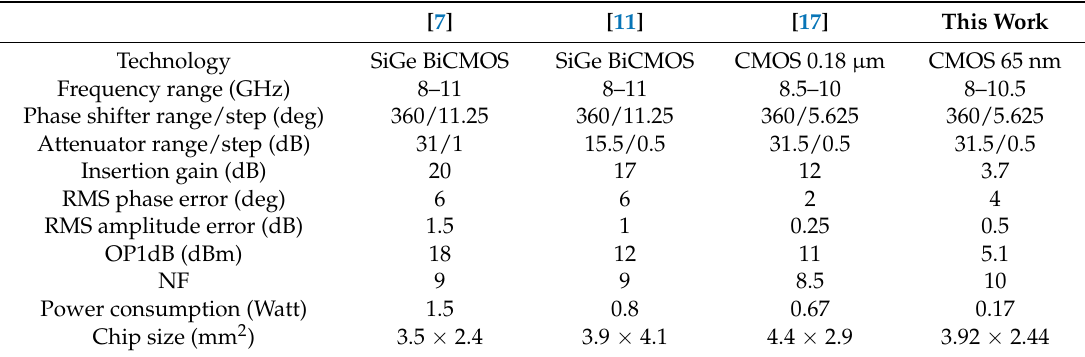
Table 5. Comparison of TRM performance for X-band phased array.